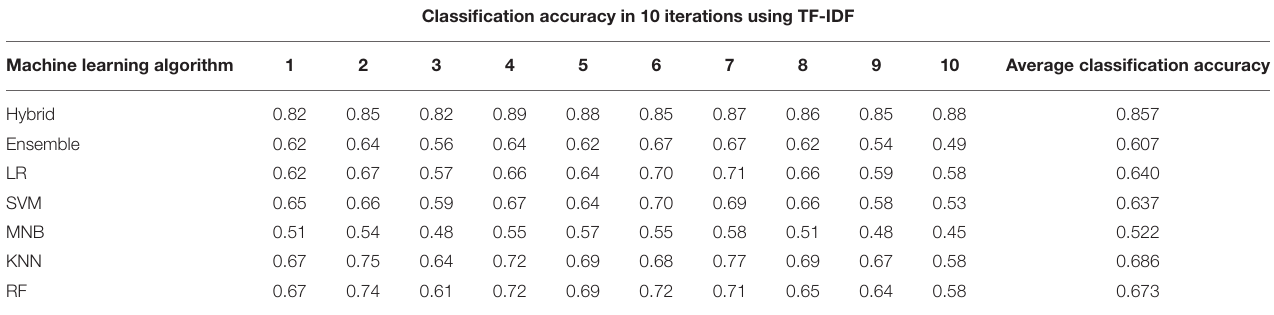
TABLE 6 | Classification accuracy of ML algorithms using Term Frequency-Inverse Document Frequency (TF-IDF).